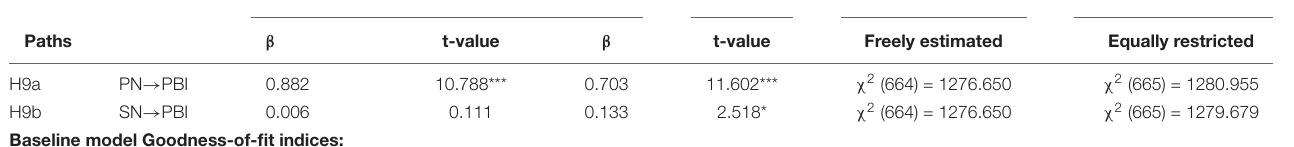
TABLE 5 | Results of the structural invariance models. Female Male Baseline model Nest model Paths t-value t-value Freely estimated Equally